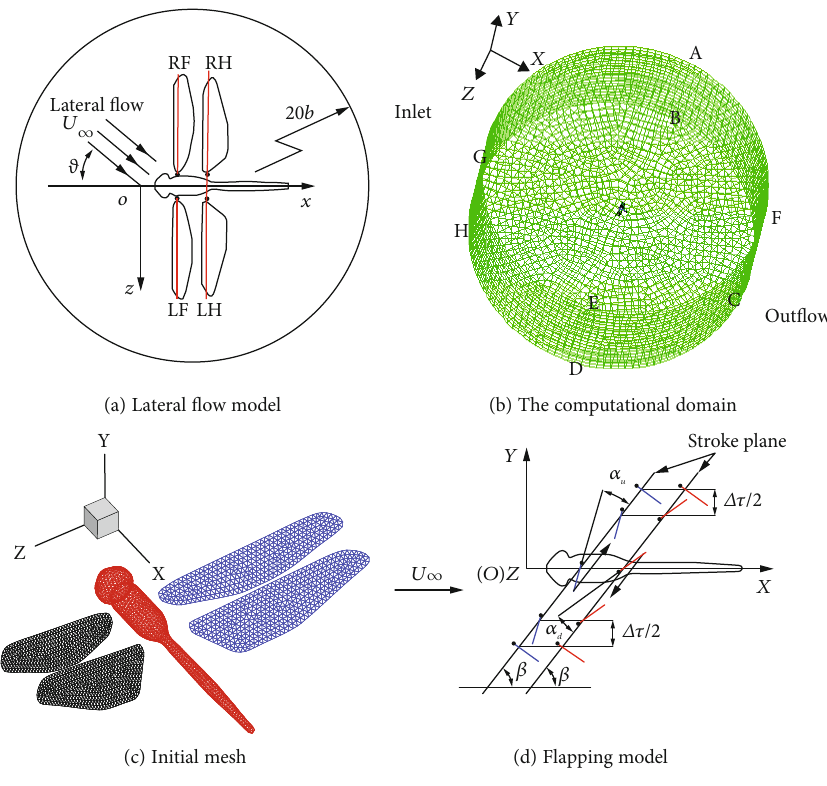
Figure 1: Lateral fl ow model and